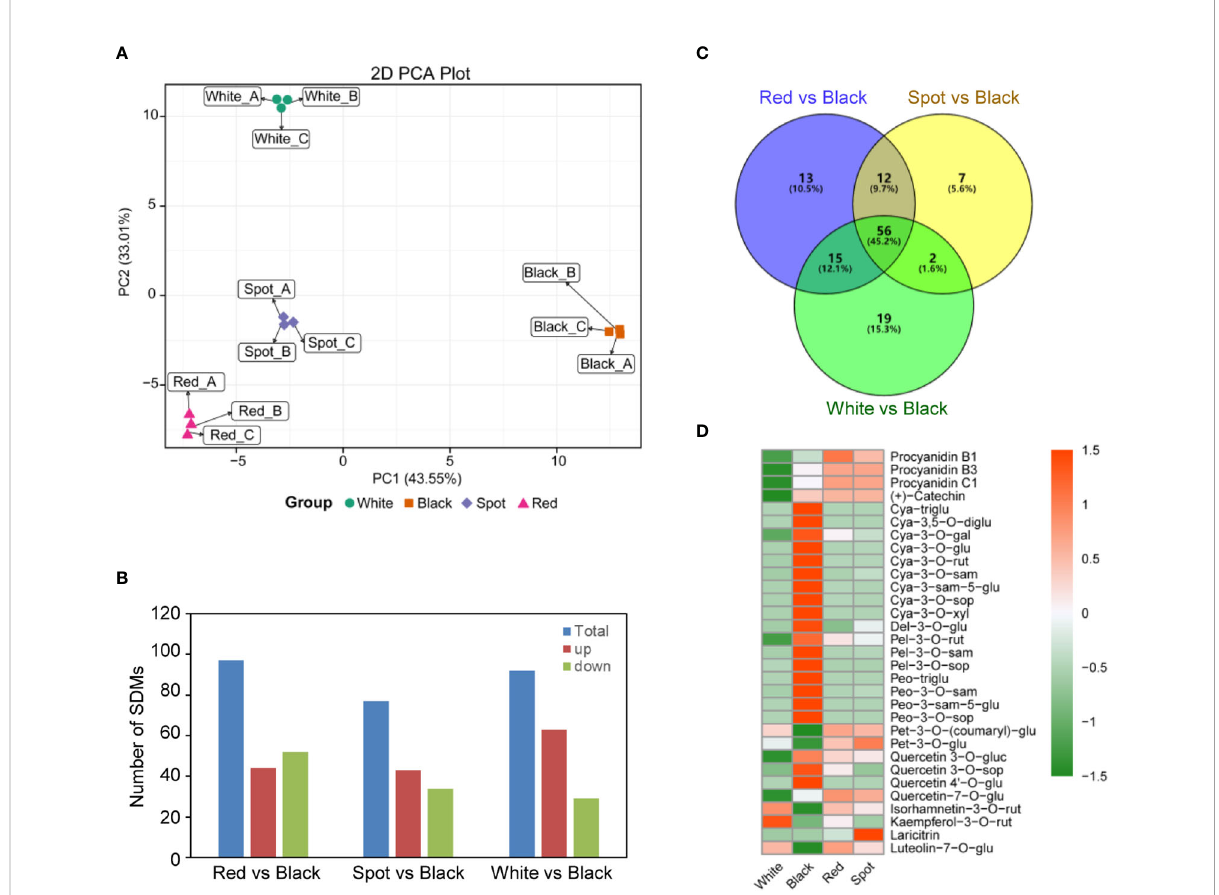
FIGURE 2 Metabolomics analysis of fl avonoid pro fi les in peanut seed coats with different testa color based on UPLC-ESI-MS/MS. (A) Principal component analysis (PCA) of metabolomics data; (B) summary of signi fi cant differential fl avonoid metabolites (SDMs) between black and other samples (Red vs Black, Spot vs Black, White vs Black); (C) venn diagram of SDMs, and (D) hierarchical clustering analysis of the abundance of 56 common SDMs shared by the three paired comparisons. The heatmap was drawn using the “ pheatmap ” package in the software R. Orange color indicates high abundance, while green is